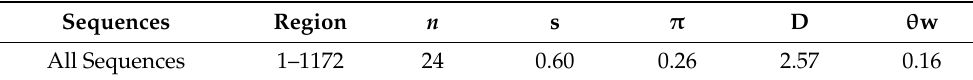
Table 3. Overview of the relationship between all studied sequences of the fad2 gene; (detect deviations from the neutral